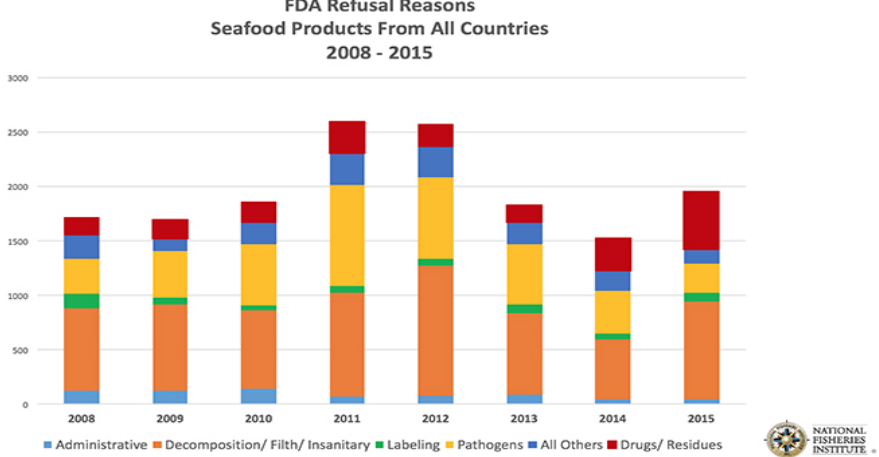
Figure 1. United States Food and Drug Administration (USFDA) Seafood Product Refusals.